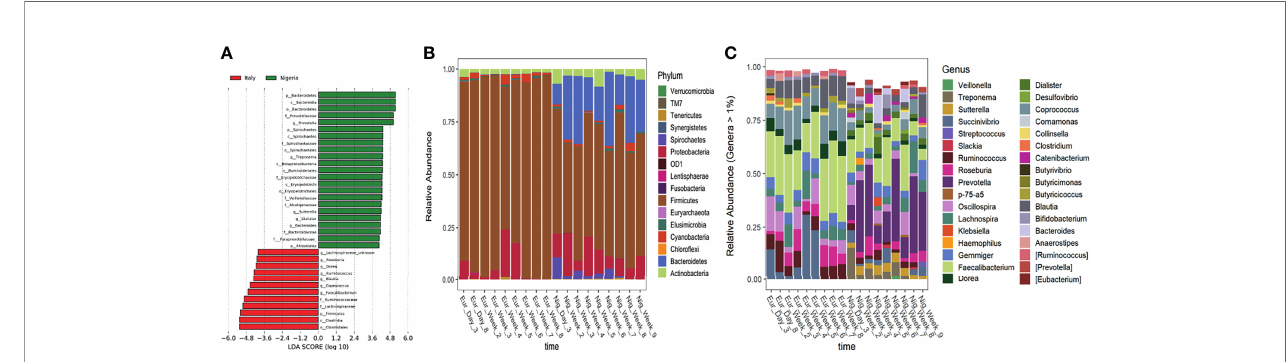
FIGURE 3 | Discriminant taxa between Italy and Nigerian stay. (A) Differentially represented taxa were identi fi ed by linear discriminant analysis (LDA) effect size (LEfSe) analysis. The logarithmic threshold for discriminative features was set to 4.0. Bar plots showing the phylum- (B) and genus-level (C) composition of microbial communities in faecal samples collected during the stay in Italy and Nigeria.